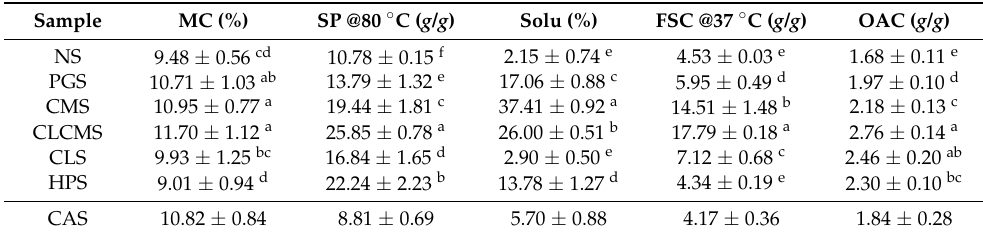
Figure 5. Swelling Power ( g/g ) and Solubility (%) of Native and Modified KJ CMU-107 Rice Starches Determined at 70 ◦ C. Determined at 70.°C . Table 2. Powder Properties of Native and Modified KJ CMU-107 Table 2. Powder Properties of Native and Modified KJ CMU-107 Starches.